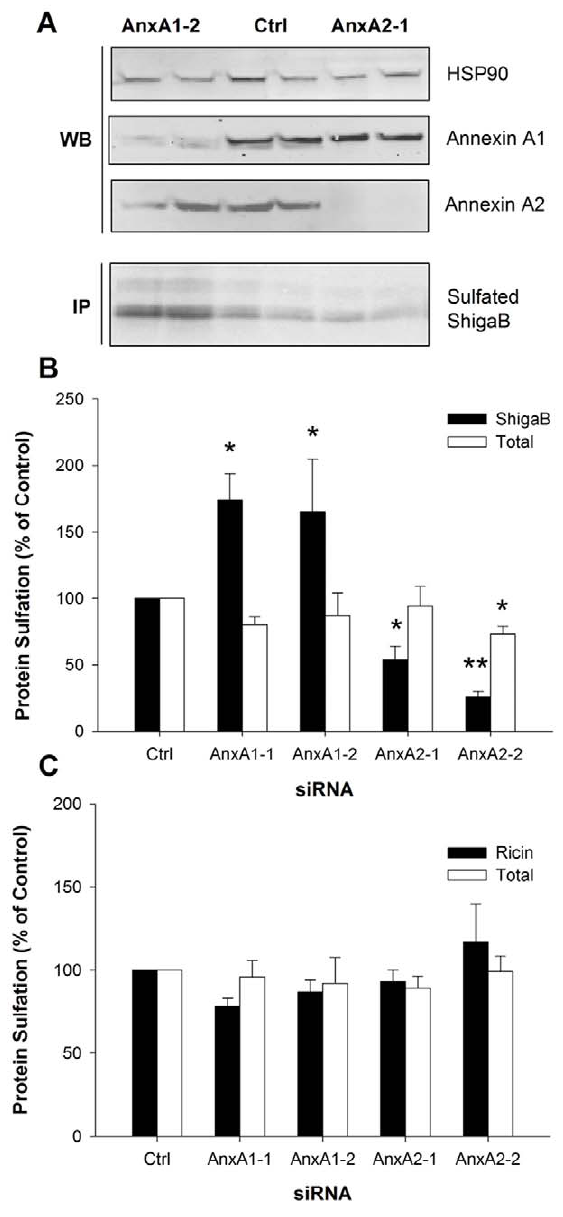
Figure 1. ShigaB transport to the Golgi is regulated by annexin A1 and A2. HeLa cells were transfected with control, annexin A1 or A2 siRNA for 72 h. For sulfation measurements, cells were starved in the presence of radioactive sulfate for 3 h. ShigaB-sulf2 or Ricin-sulf1 was then added and the incubation proceeded for an additional one or two hours, respectively. Cells were lyzed, ShigaB or ricin immunoprecipitat- ed, separated by electrophoresis and analyzed by autoradiography. The protein knockdown level was investigated in total cell lysates by immunoblotting. (A) Cell lysates were analyzed by western blotting (upper panel) with the indicated antibodies demonstrating protein knockdown of annexin A1 and A2 by the indicated siRNA oligos. Hsp90 represents loading control. Autoradiography (lower panel) showing results from the corresponding sulfation experiment. (B) and (C) Quantative data from protein sulfation for ShigaB and ricin respectively, plotted as percentages of control values. Quantifications of sulfation are the average of 3–8 independent experiments, each performed in parallel, error bars indicating standard error of the mean; *p , 0.05, **p , 0.005 indicate statistically significant